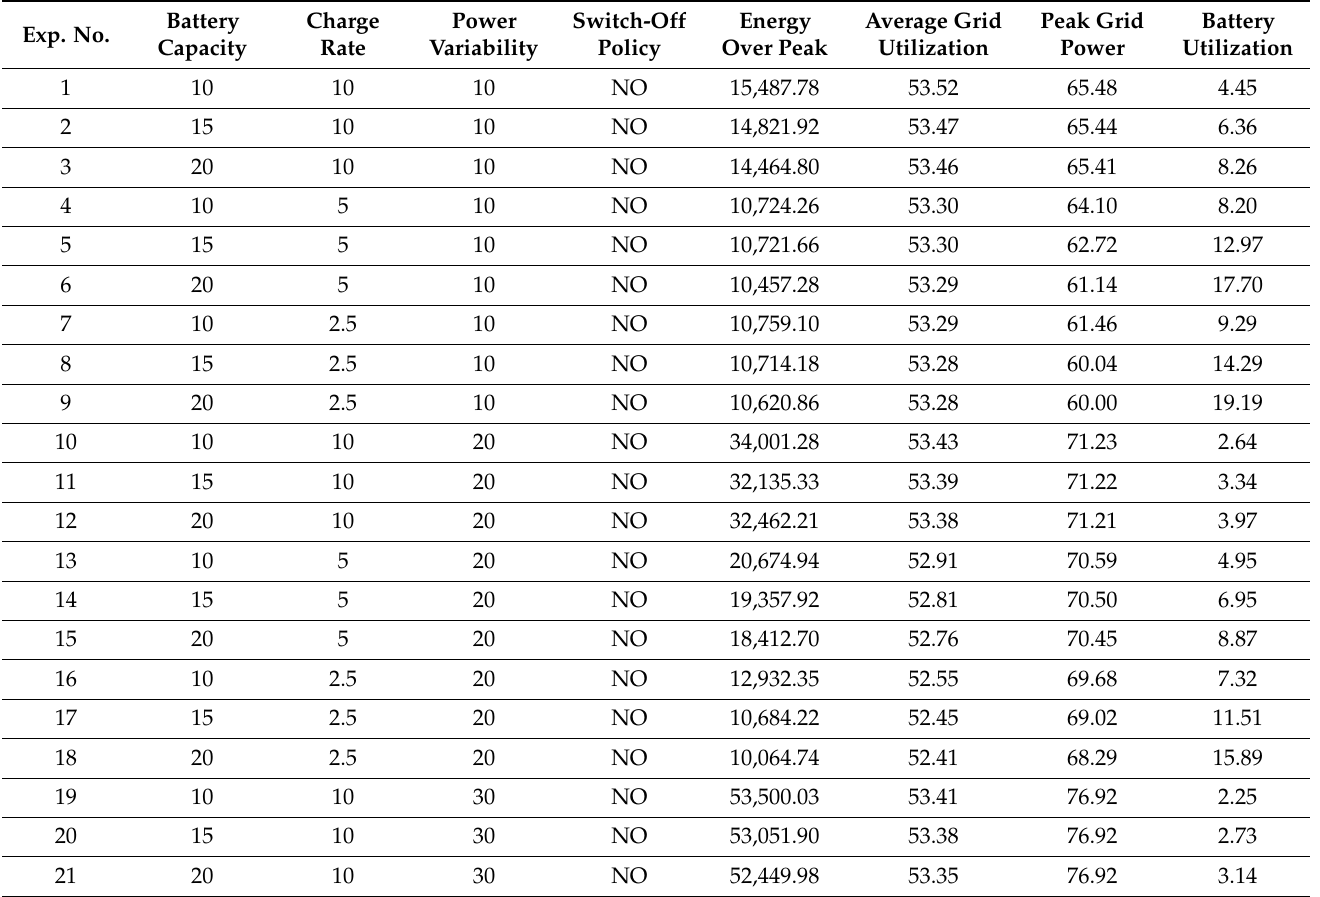
Table A2. Main data used for the simulation